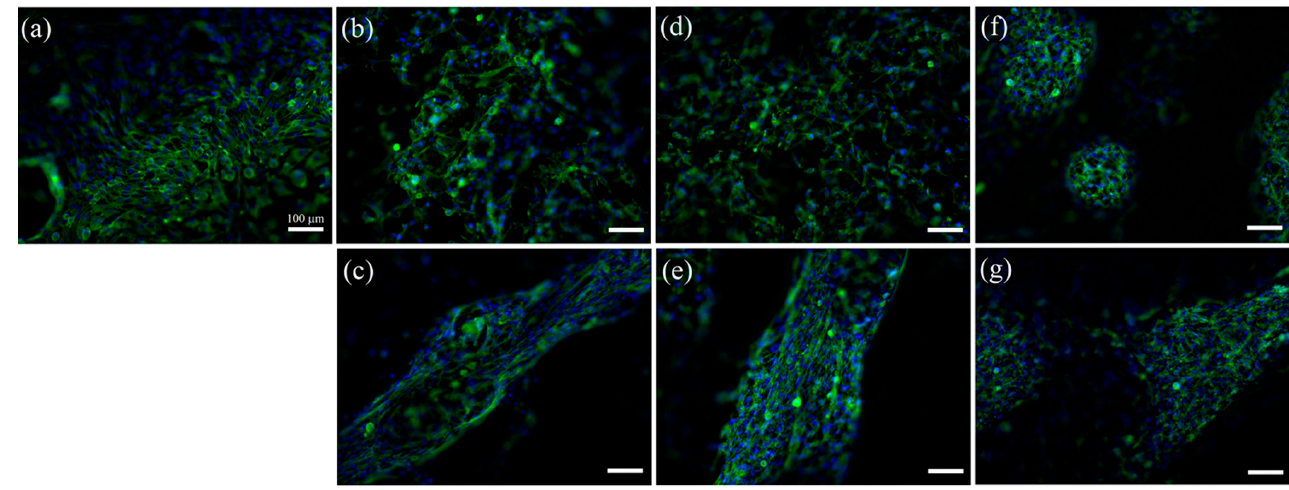
Figure 6. Fluorescence images of C2C12 cells cultured for 6 days in serum-rich medium on ( a ) 20 mg.mL − 1 fibrin; ( b , c ) 20 mg.mL − 1 fibrin with 2.5 mg.mL − 1 collagen ( d , e ) 20 mg.mL − 1 fibrin and 5 mg.mL − 1 collagen; ( f , g ) 20 mg.mL − 1 fibrin with 10 mg.mL − 1 collagen. (Blue: DAPI, green: Alexa Fluor 488 Phalloidin). (Scale bar = 100 μ m).